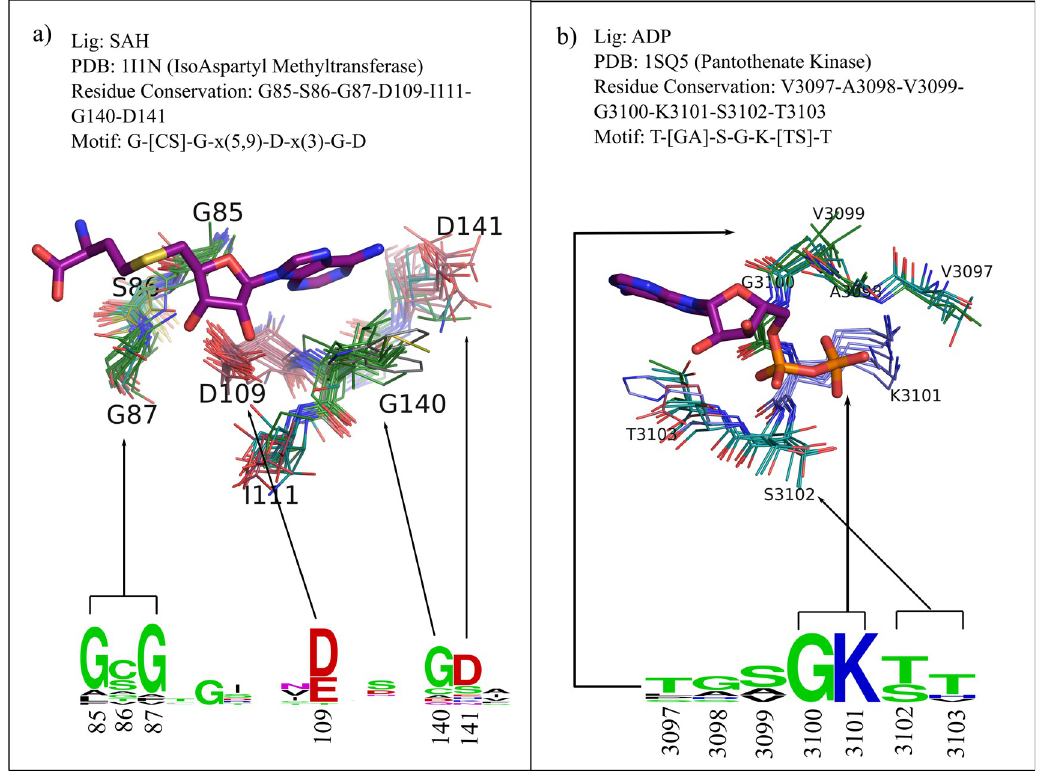
Fig 3. Alignment output from SiteMotif showing site conservation in the binding sites of proteins having no sequence relationships in 2 different cases. A) SAH binding proteins—7 site residues are very well aligned in all structures (31 structures belonging to 31 different families); sequence GSG was highly conserved near the methionine moiety of the ligand. Two negatively charged residues D109, D141 positioned appropriately to make strong hydrogen bonds with the SAH are observed. B) ADP binding proteins—Sites from 11 different proteins belonging to 11 different families show excellent alignment in 7 site residues. An amino acid segment TGSGK was observed to be a conserved structural motif. This includes a lysine (K3101), making hydrogen bonds with the β -phosphate of